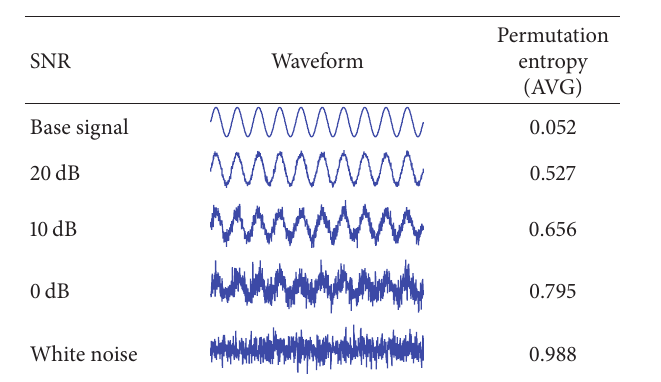
Table 1: Average of permutation entropy of test signal under various SNR.